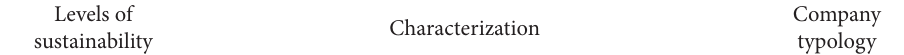
Table 4. Characterization of sustainability levels by type of